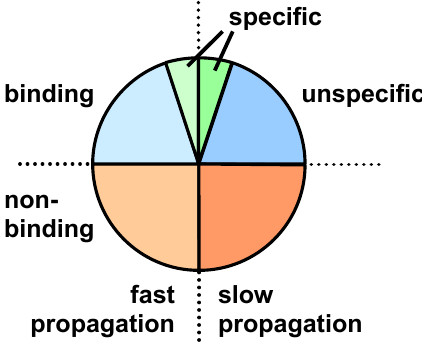
Figure 5. Schematic representation of the different types of phages with respect to their target binding and evolutionary